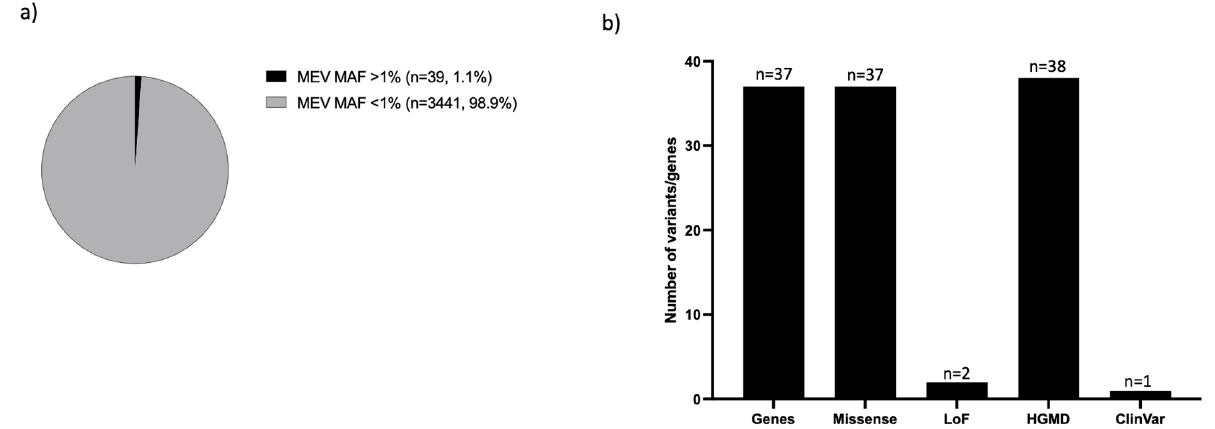
Figure 2. Characterization of common Middle East disease variants (CMEDVs). ( a ) Percentage of CMDEVs (MEV MAF >1%) and rare (MEV MAF <1%) set represents variants DM, or P/LP, which are also rare (<1%), in gnomAD. ( b ) Effect of CMEDVs and total number of genes impacted by those variants and distribution of CMEDVs, which are reported at different star levels in ClinVar and HGMD. Number of variants = Number of variants that are Missense or LoFs, or are in HGMD and ClinVar. Number of genes = Number of genes in CMEDV.